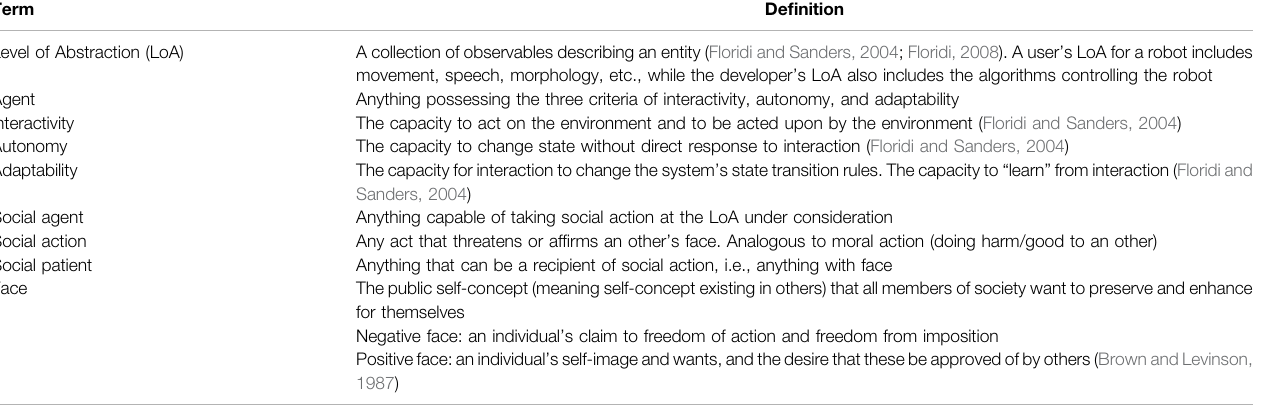
TABLE 1 | Summary of terms that are important to our concept of social agency. Term De fi nition Level of Abstraction